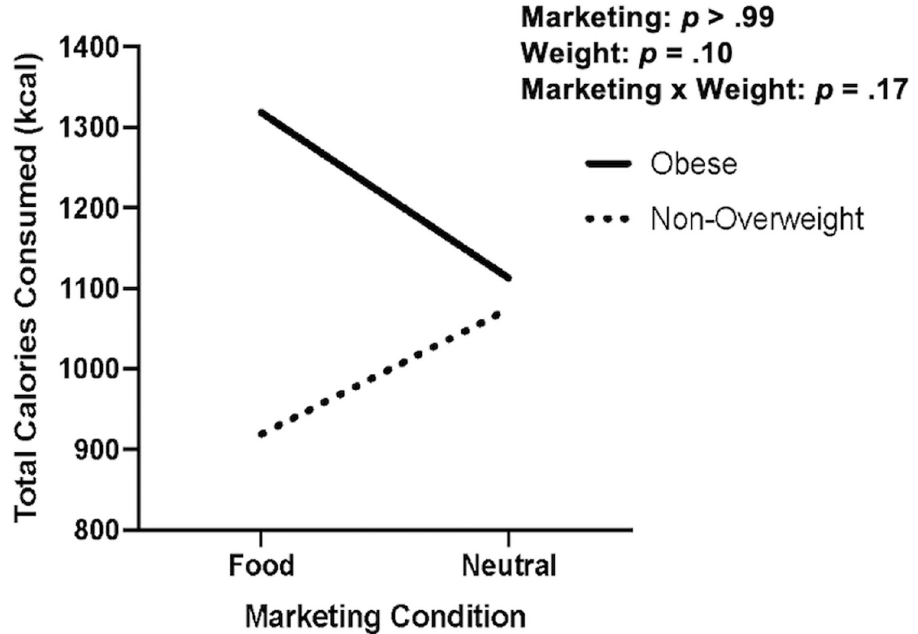
Fig 2. Difference in consumption of calories among adolescents with and without obesity. Difference in consumption of Calories among adolescents with and without obesity in the food and neutral marketing conditions. Among adolescents in the food marketing condition, adolescents with obesity consumed 399.58 kcal more than non- overweight adolescents compared to adolescents with obesity in the neutral marketing condition who consumed 37.94 kcal more than non-overweight adolescents. Although results were not significant, there was a small-to-medium effect size (partial η 2 = .06) for this difference.